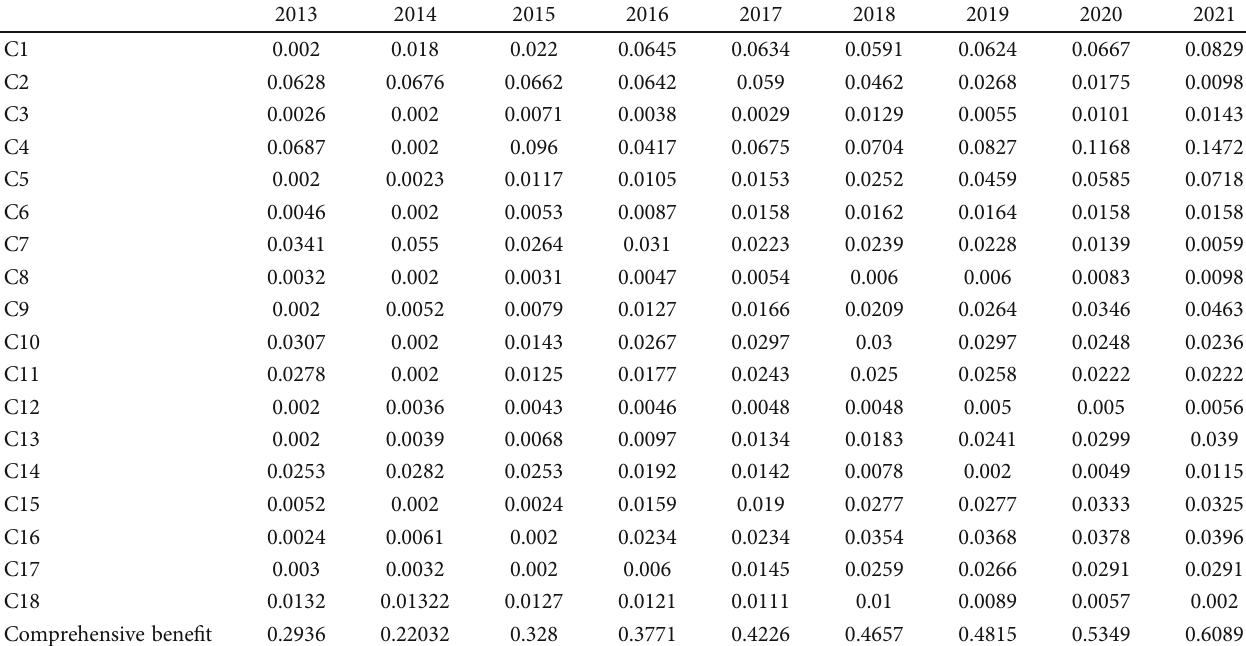
Table 7: Comprehensive land use bene fi ts of 18 selected